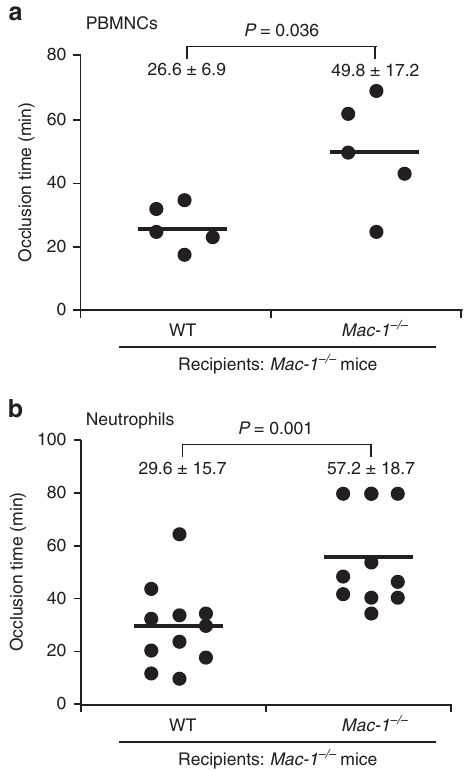
Figure 3 | Adoptive transfer of WT leukocytes rescues the thrombus defect in Mac-1 (cid:2) / (cid:2) mice. Thrombotic occlusion times in Mac-1 (cid:2) / (cid:2) recipient mice undergoing adoptive transfer of 1 (cid:3) 10 6 WT or Mac-1 (cid:2) / (cid:2) PBMCs ( a ) or neutrophils ( b ) via tail vein injection before carotid artery photochemical injury (mean ± s.d.). Each data point is from one mouse received WTor Mac-1 (cid:2) / (cid:2) PBMCs or neutrophils as indicated. P values are obtained by unpaired two-tailed t-